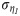
Hierarchical network in regime III outperforms linear network as uncertainty increases.HN: Hierarchical Network; LN: Linear Network; J+/purple: HN intermediate layer excitatory weight; J−/turquoise: HN intermediate layer inhibitory weight; σηI: environmental uncertainty; white outline: regime I. (A) Performance of HN relative to LN improves across offers as uncertainty increases. Networks were presented with 640 unique offers. The proportion of offers for which networks chose the larger combined alternative was measured. Heatmaps show the proportion of offers where the HN is more likely than the LN to chose the larger alternative. HN E/I tone are given on the X-axis and Y-axis respectively. (Top) Relative performance with no environmental uncertainty. (Bottom) Relative performance at high environmental uncertainty. (B) The mean of HN E/I tones and the best HN E/I tone both improve in performance relative to the LN as uncertainty increases. The X-axis indicates the amount of environmental uncertainty, while the Y-axis indicates the proportion of offers the HN displays better performance than the LN. The ‘x’ markers indicate the mean of all E/I tones in (A), while the dots indicate relative performance of the best E/I tone. (C) Best-performing inhibitory tone increases with uncertainty. Excitatory and inhibitory weights are given for the best performing HN intermediate layer E/I tone at each uncertainty level. A sigmoid function was fit to the points. (D) The indifference curvature of HN high-performing E/I tones becomes increasingly concave. The curvature is given as a function of environmental uncertainty for the best-performing E/I tone. (E) Performance of regime III degrades less with uncertainty relative to regimes I and II or the linear network. Values and linear fits are given for the LN, and as well as weight configurations representing the three HN network regimes (regime I: J+ = 0.34, J− = −0.01; regime II: J+ = 0.36, J− = −0.0; regime III: J+ = 0.32, J− = −0.1).